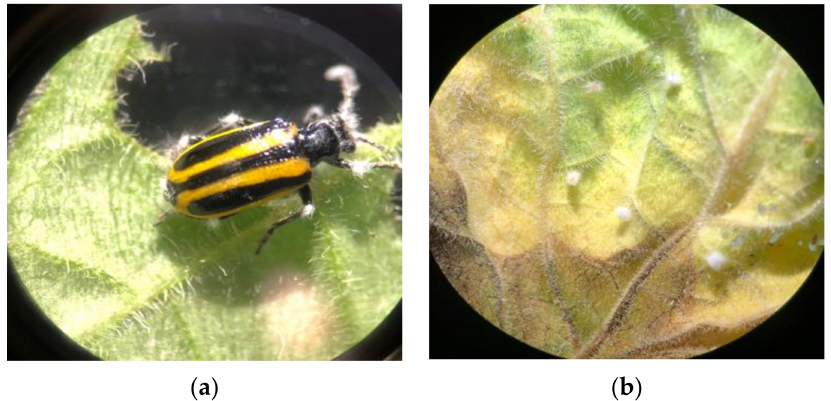
Figure 2. Photographs of Lema bilineata showing signs of fungal extrusion: ( a ) adult with first signs of fungal extrusion; ( b ) eggs with fungal extrusion.